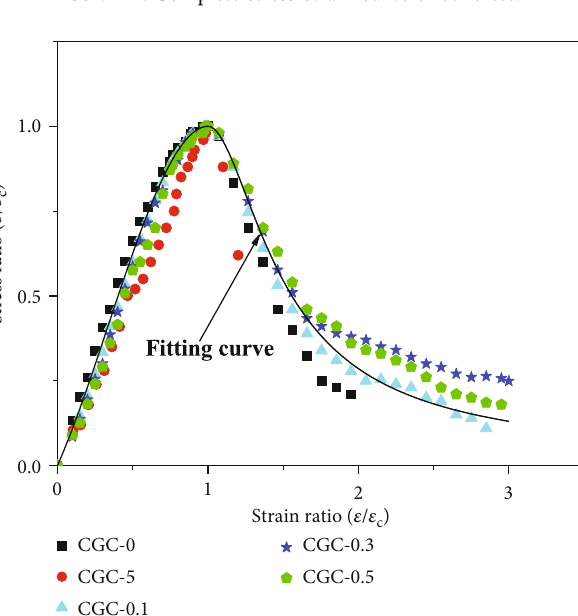
Figure 12: Flexural strength.